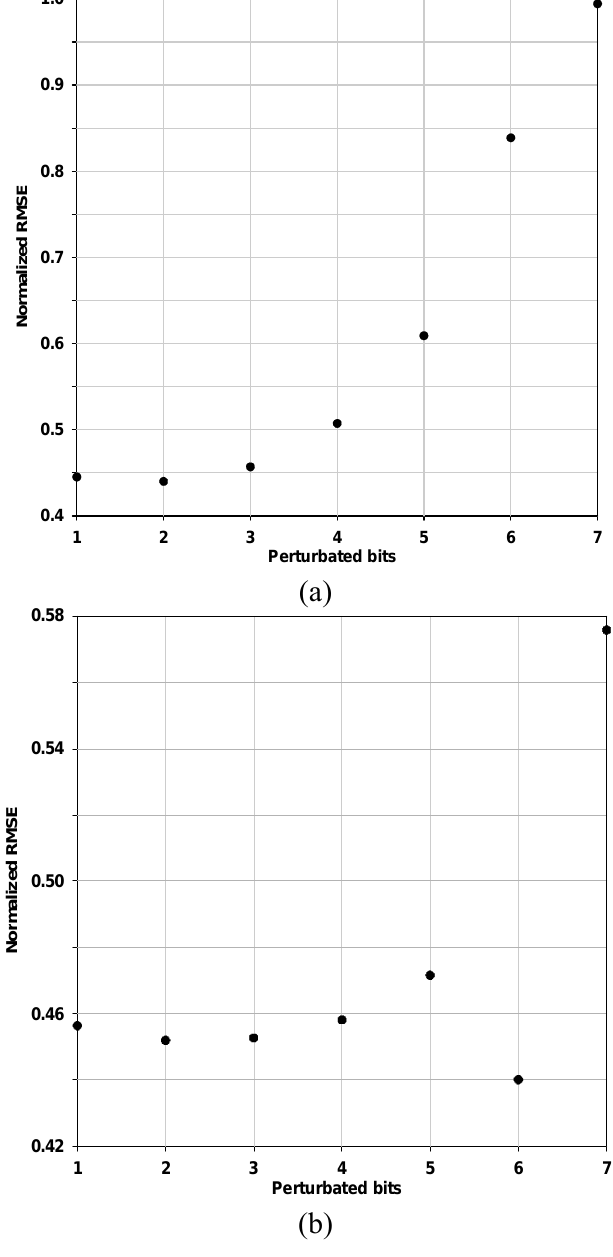
Figure 11. (a) RMSE vs. number of bits perturbed (multiple parameter algorithm). (b) RMSE vs. number of bits perturbed (single parameter